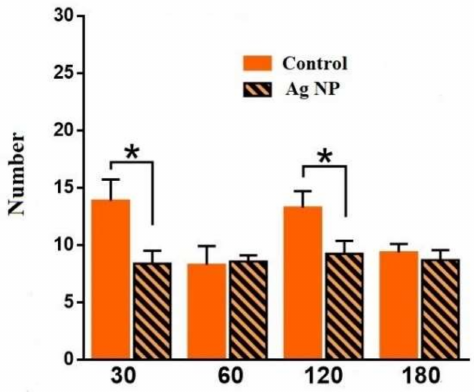
Figure 10. Number of times that mice peeped out of the dark chamber into the light chamber for the different periods of the experiment.